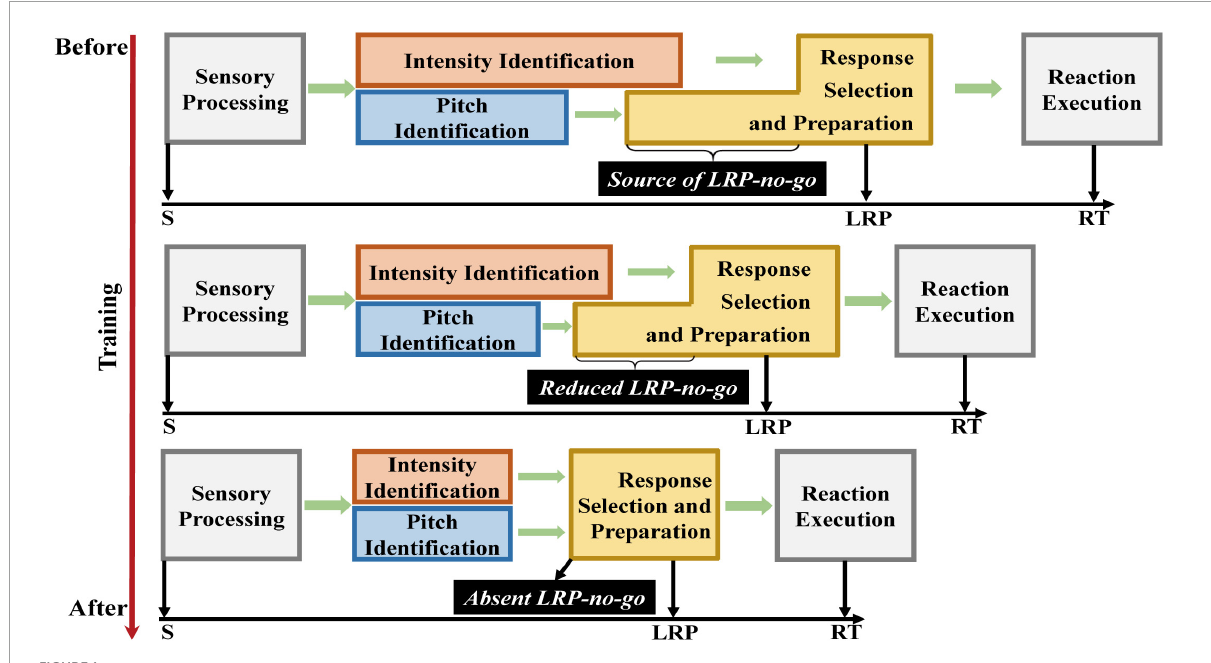
FIGURE1 The model showing how training reduces processing times for intensity and pitch until they are comparable and the S-LRP disappears, indicating the development from an asynchronous pattern to a synchronous one. S: Stimulus onset; RT: Reaction time. This Figure is adapted from Miller’s Figure 1 in 1992 (Miller and Hackley, 1992) and Gong’s Figure 5 (Gong et al.,